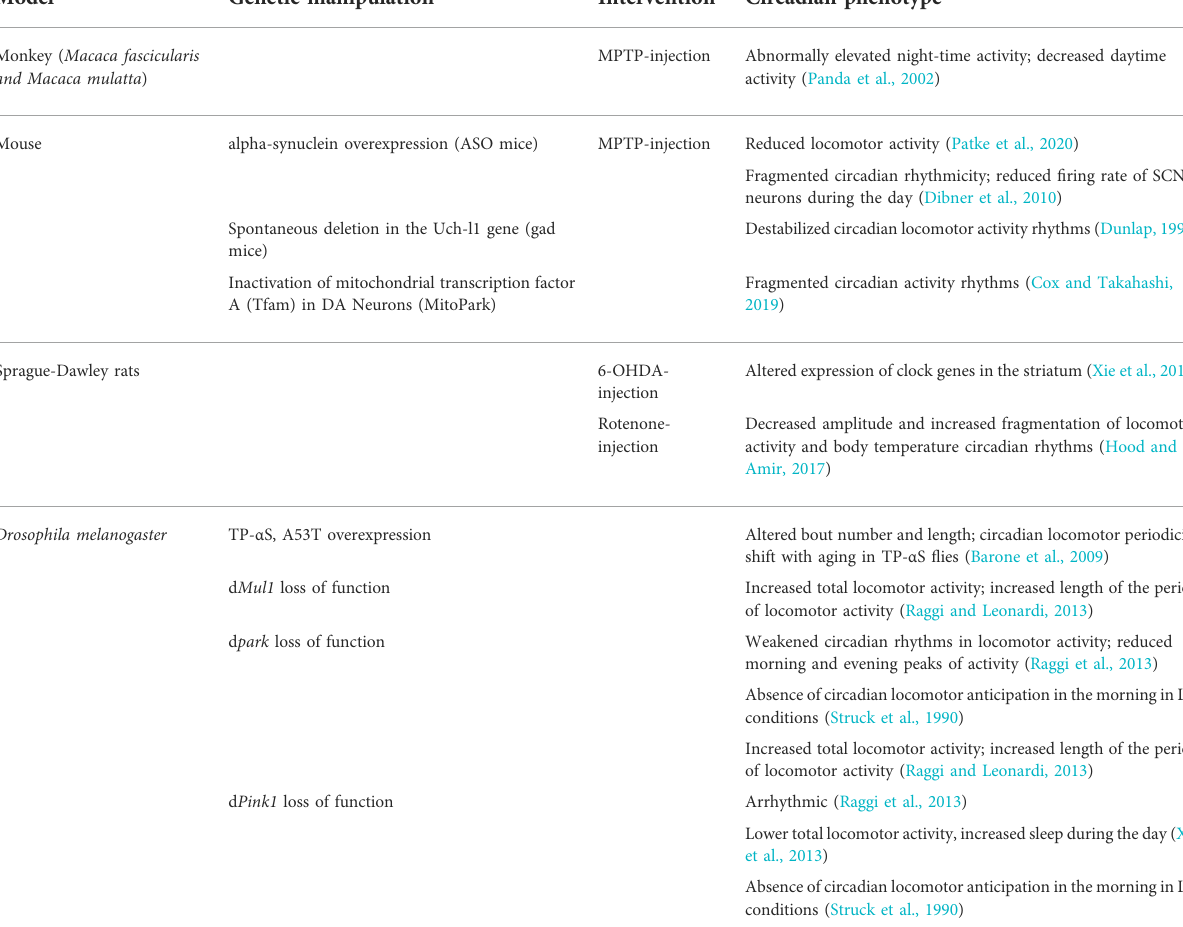
TABLE 1 Animal models in Parkinson ’ s